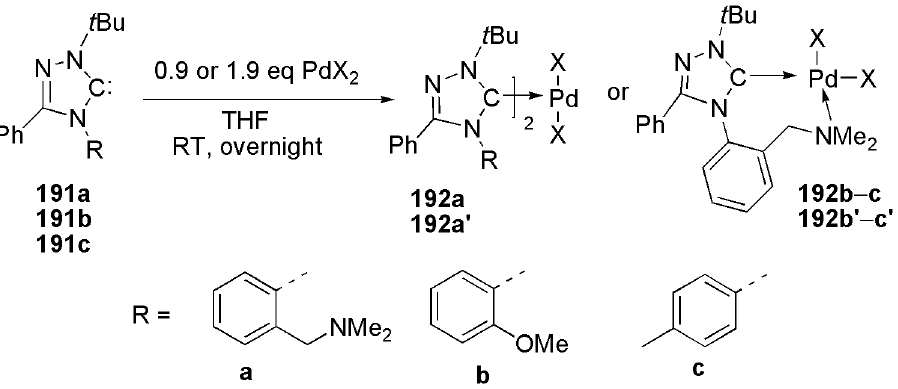
NHC ligands have significant impact in their catalytic